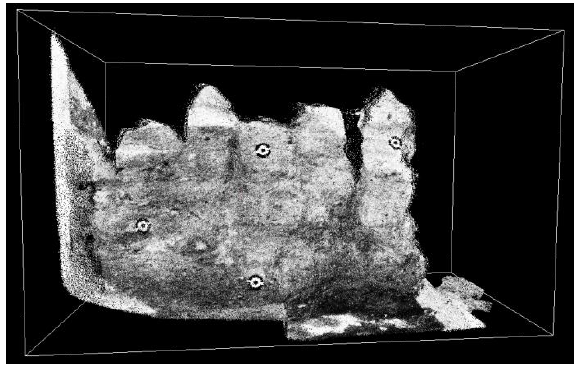
Figure 4. TLS point cloud after registration of 5 positions